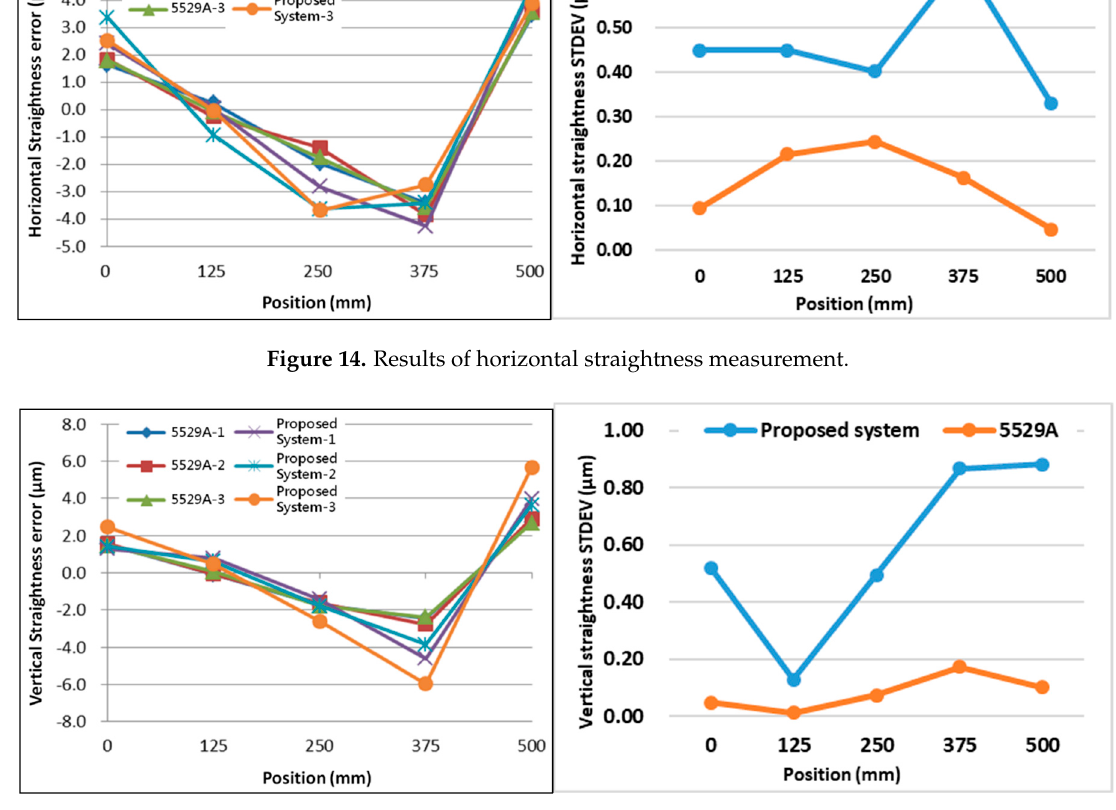
Figure 15. Results of vertical straightness measurement. Appl. Sci. 2018 , 8 , x FOR PEER REVIEW